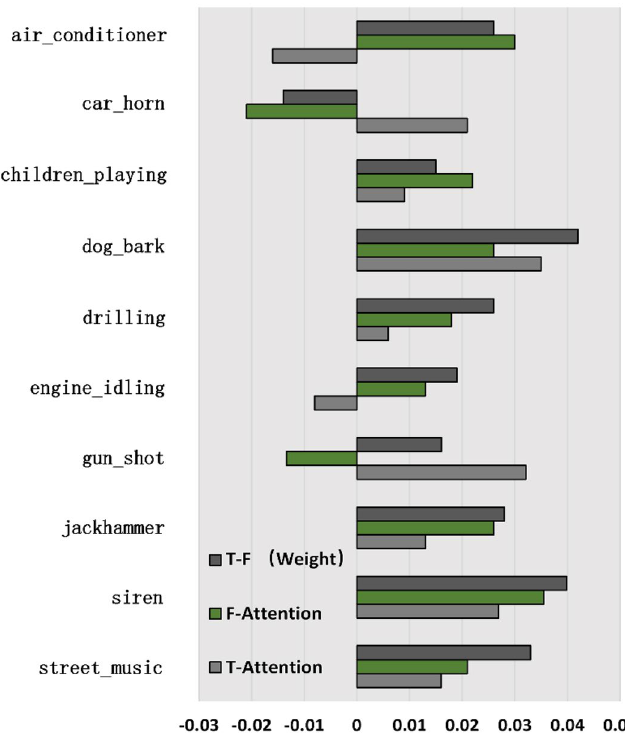
Figure 7. The difference of classification accuracy of each sound event after using different attention mechanisms on the UrbanSound8K datasets.